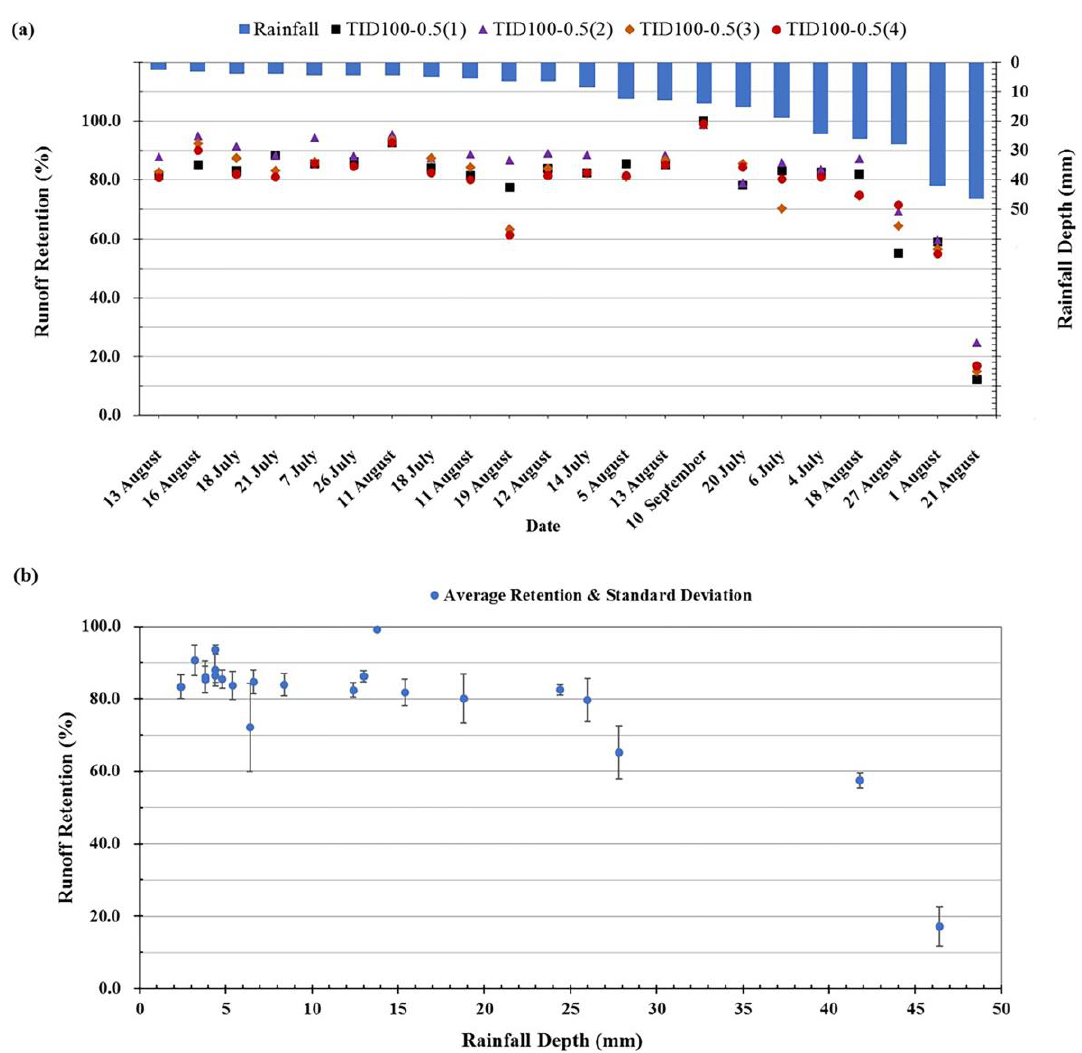
Figure 2. For the four TID100-0.5 modules: ( a ) runoff retention rates for 22 rainfall events and 6-h MIDPs (sorted by depth); ( b ) average retention rates and standard deviation for each event.